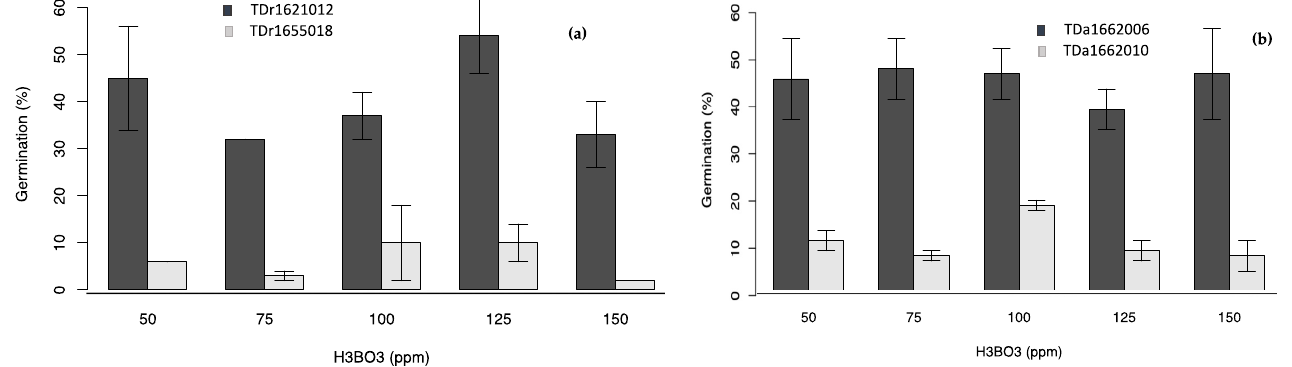
Figure 2. Effects of boric acid on pollen germination of genotypes of ( a ) D. rotundata , ( b ) D. alata.